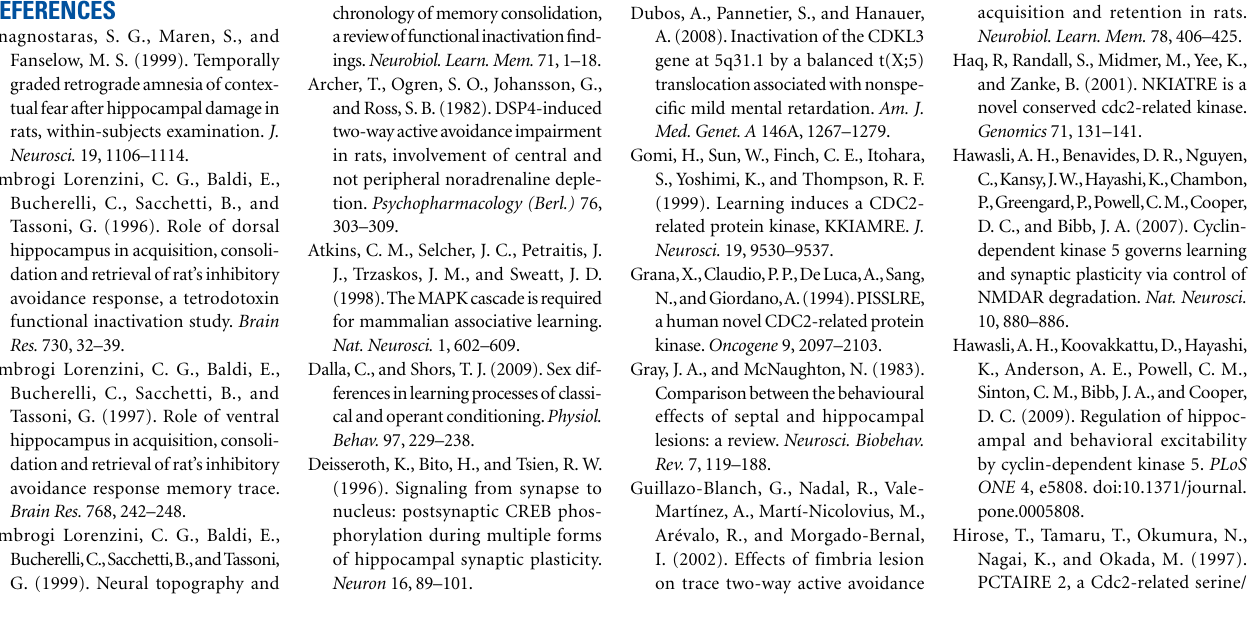
mild IDD (Dubos et al., 2008). The expression of Cdkl5 in mice